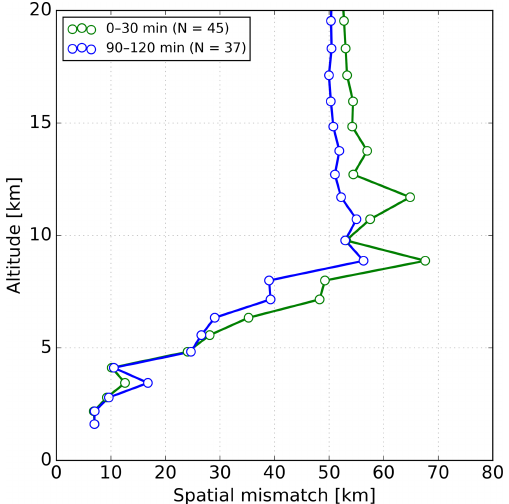
Figure 7. Vertical profile of the horizontal spatial mismatch be- tween FTIR and sonde profiles in BLD. As an example two co- incident time intervals are